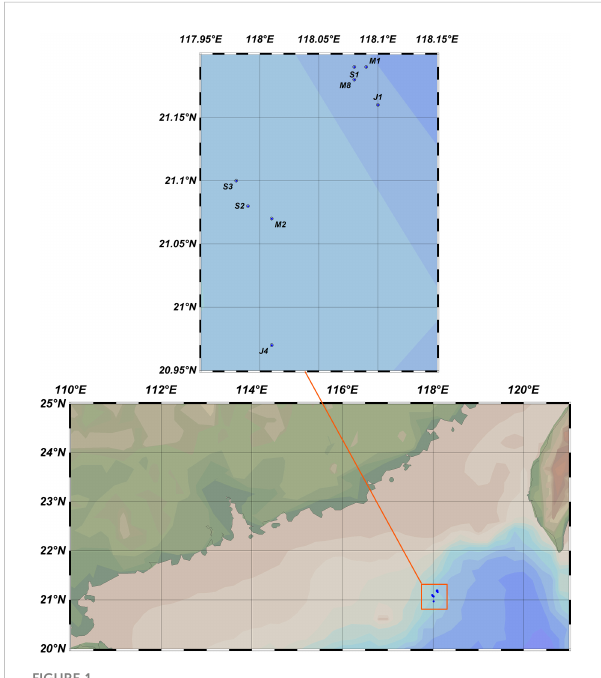
FIGURE 1 Sampling stations in the South China Sea (map made by Ocean Data View, Schlitzer, Reiner, Ocean Data View, odv.awi.de,